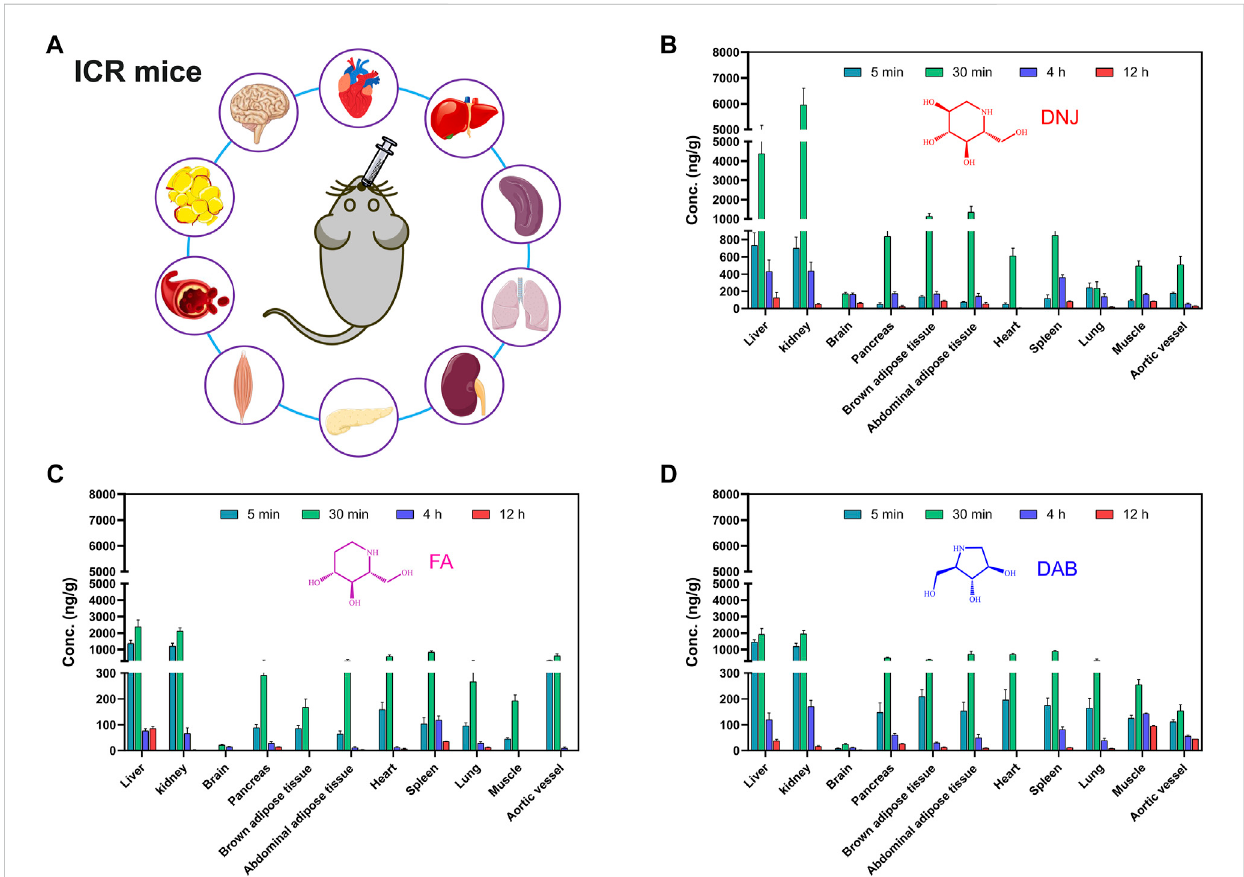
FIGURE 5 Experimental scheme of tissue concentration determination after oral administration of SZ-A in mice (A) . The concentration of the three active components of SZ-A, including DNJ (B) , FA (C) , and DAB (D) , in tissues, including heart, liver, spleen, lung, kidney, aortic blood vessels, brown adipose tissue,abdominal adiposetissue,muscle, pancreas, andbrain, after asingle oraladministrationofSZ-A(20 mg/kg)inICR mice.Eachvaluerepresentsthe mean ± standard error of mean (SEM) ( n =